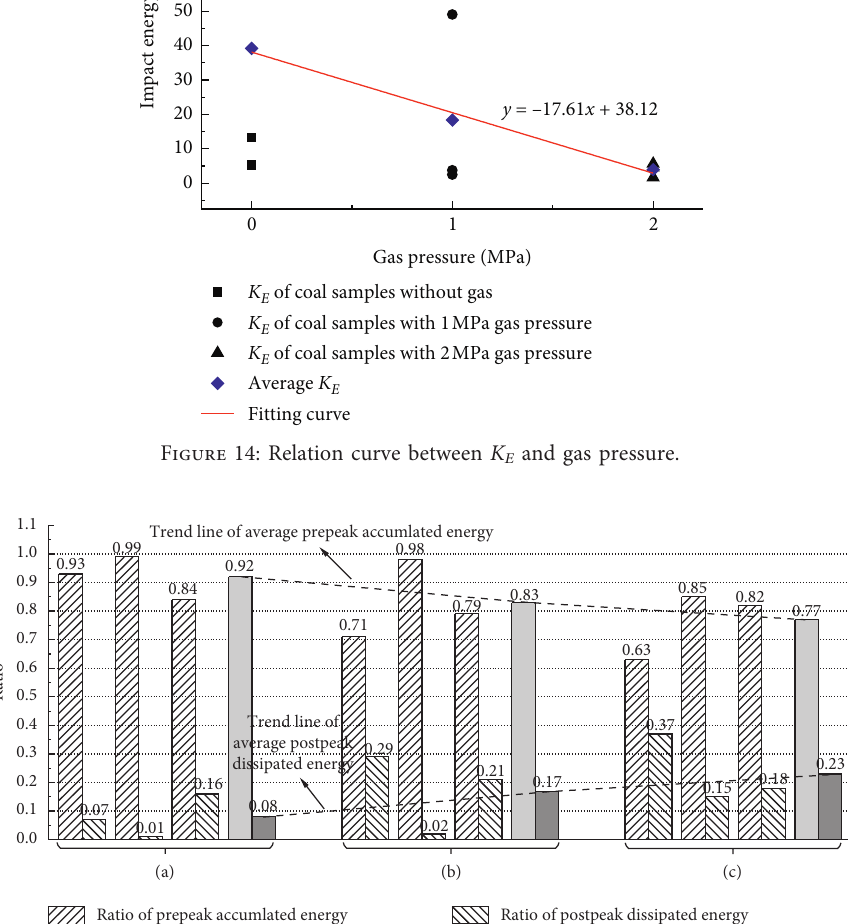
Figure 15: Ratio of prepeak energy and postpeak energy of gas-containing coal. (a) Coal samples without gas. (b) Coal samples with 1MPa gas pressure. (c) Coal samples with 2MPa gas